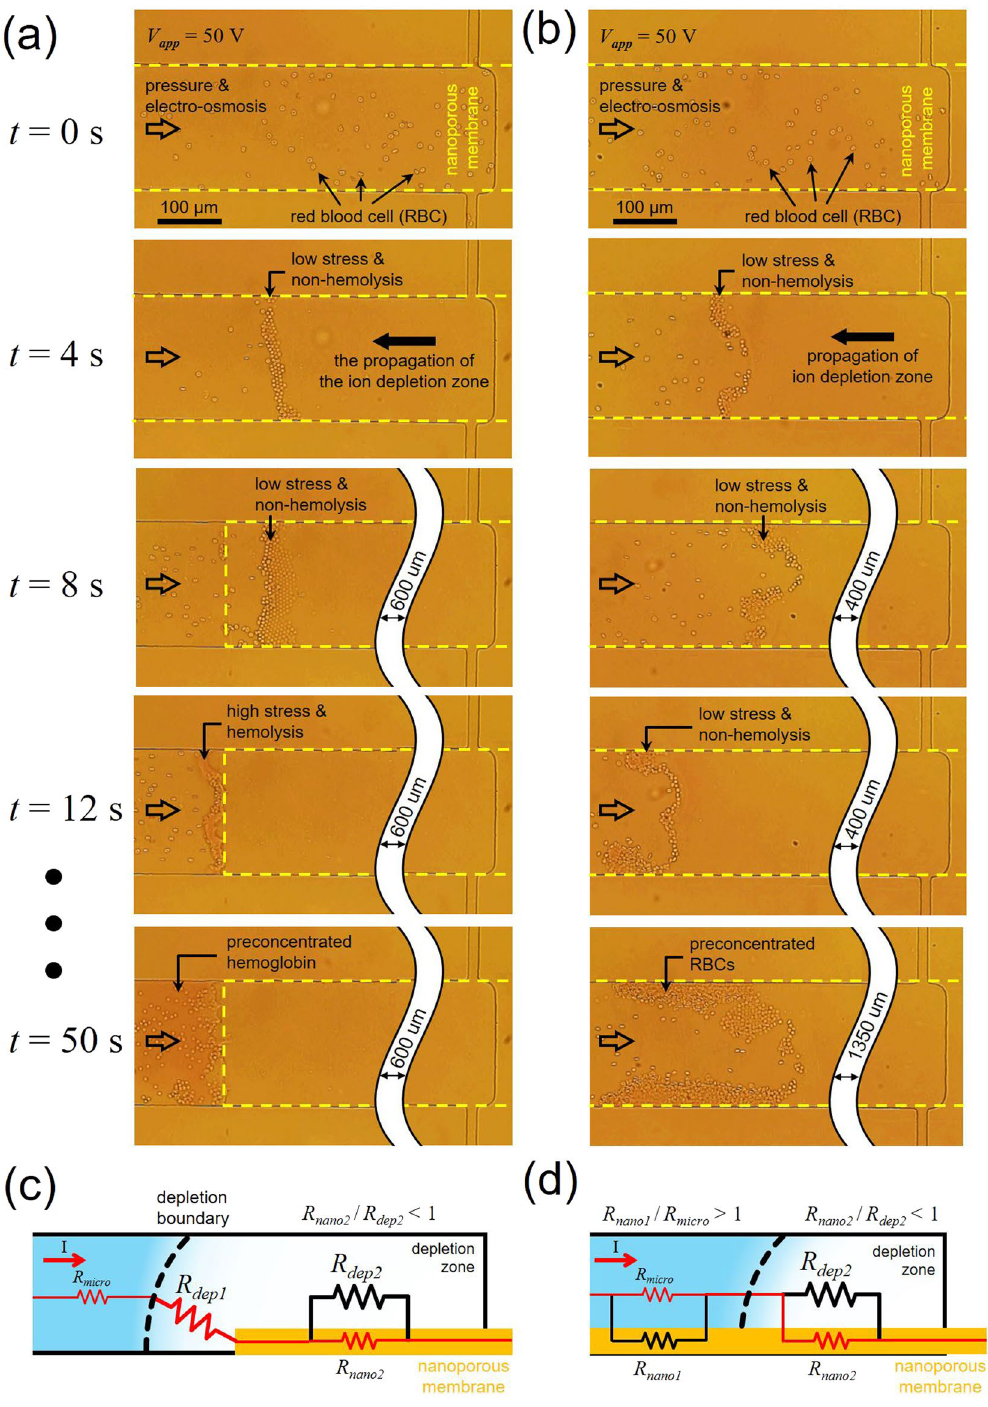
Figure 6. Time-revolving snapshots of RBC preconcentration with the devices of protruded membrane length ( a ) L = 1000 um and ( b ) L = 6500 um. The amplification ratio of RBCs were ~40 fold in ( b ), while most of RBCs were destroyed in ( a ). See supporting video for each figures. In terms of the current path, the schematic diagrams of developed ion depletion zone at t = 50 sec for each cases were depicted in ( c ) and ( d ) (not to